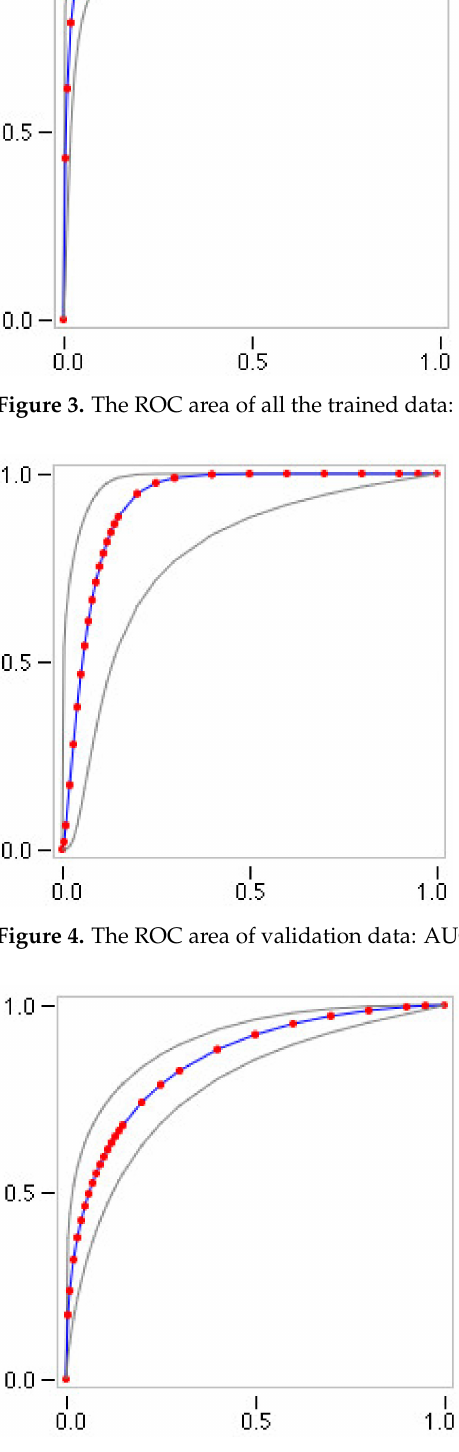
Figure 5. The ROC area of all the modified trained data: AUC